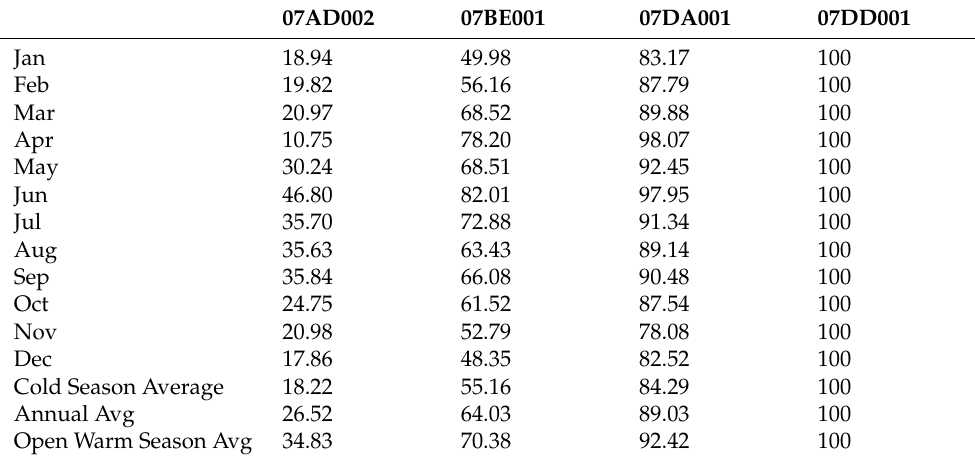
Table 7. Average flow at hydrometric stations at Hinton (07AD002, u3), Athabasca (07BE001, m6), and below Fort McMurray (07DA001, l2) as a percentage of flow at the outlet Embarras Airport (07DD001, l3) for the years 2015, 2018, and